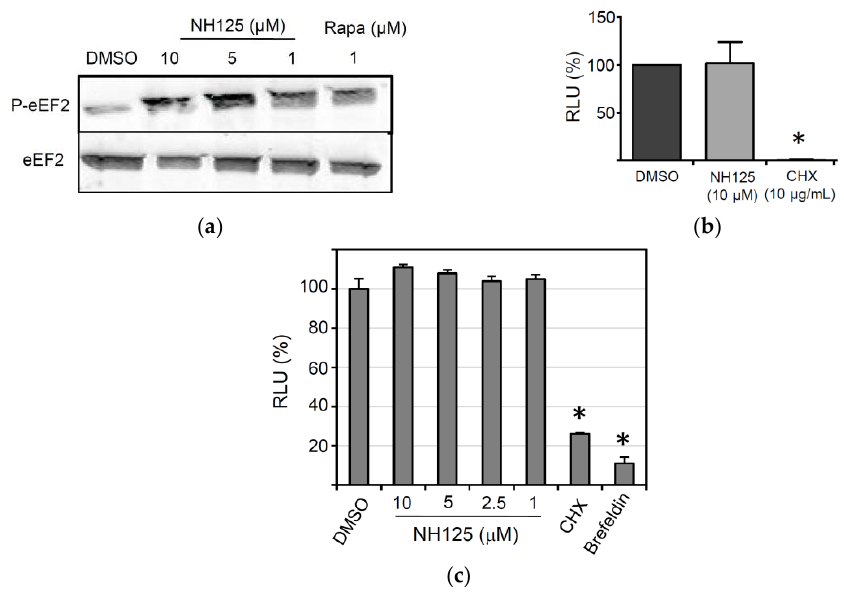
Figure 4. Impact of NH125 on eEF2 phosphorylation and protein synthesis. ( a ) Detection of eEF2 phosphorylation in HeLa cells. The cells were treated for 8 h with NH125, rapamycin or DMSO prior to lysis and Western blot analysis with antibodies directed to eEF2 and phosphorylated eEF2 (P-eEF2). ( b ) Effect of NH125 on in vitro translation of firefly luciferase mRNA. In vitro transcribed luciferase mRNA was incubated for 2 h at room temperature with rabbit reticulocyte lysates in the presence of either NH125 (10 µ M), DMSO (0.1%, v / v ) or cycloheximide (CHX; 10 µ g/mL).